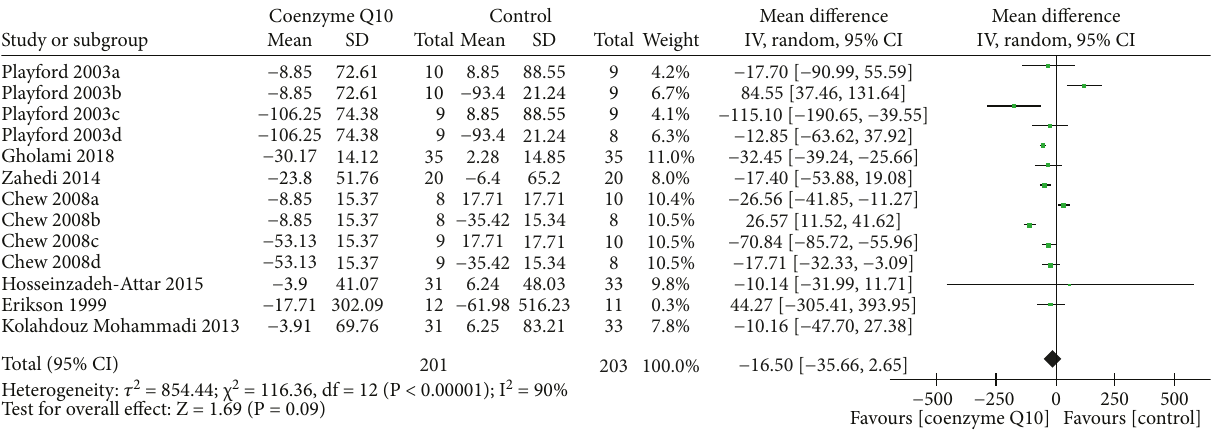
Figure 8: Triglyceride.